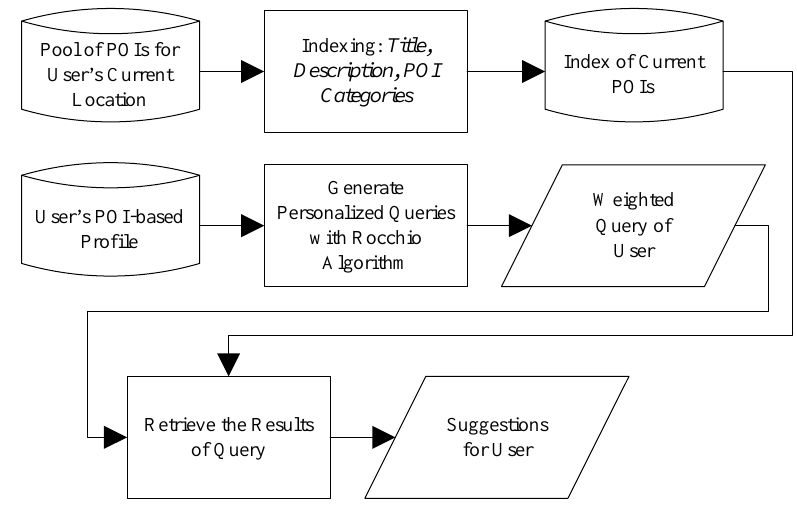
Figure 5. The Rocchio-like contextual suggestion